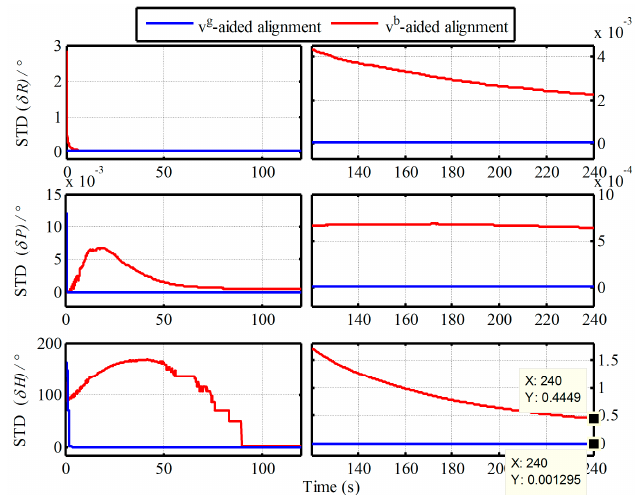
Figure 4. Curves of standard deviation (STD) of 50 alignment results.